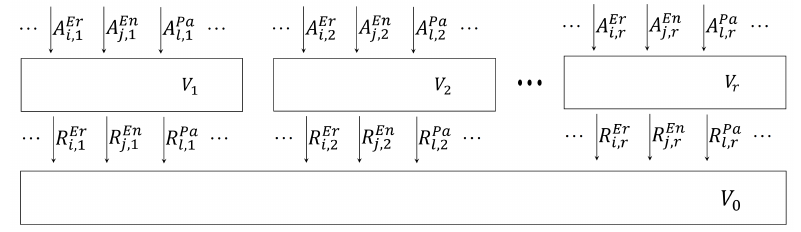
Figure 1. Scheme of the multi-service overflow